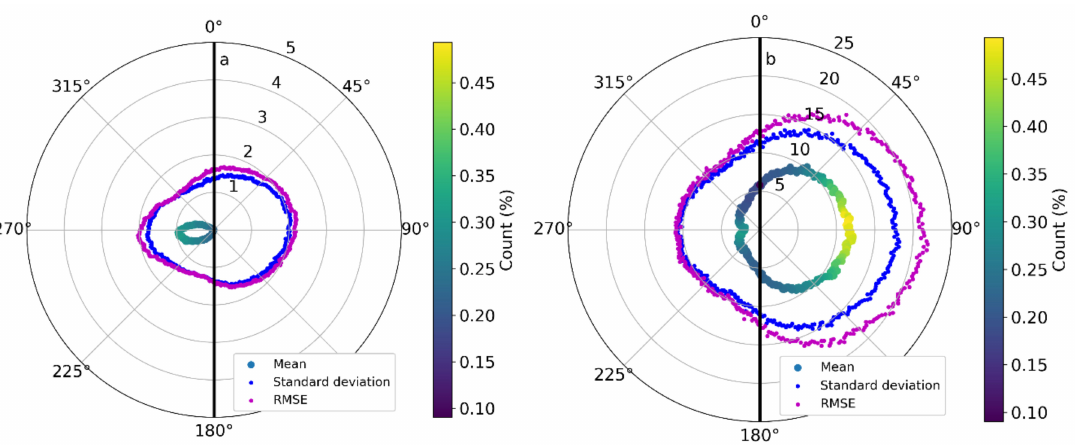
Figure 11. Influence of the slope orientation on difference of elevation ( a ) and difference of slope ( b ). The bold black line represents the flight direction, and the illumination direction is from left to right (the right-hand half of the disks represents slopes facing away from the